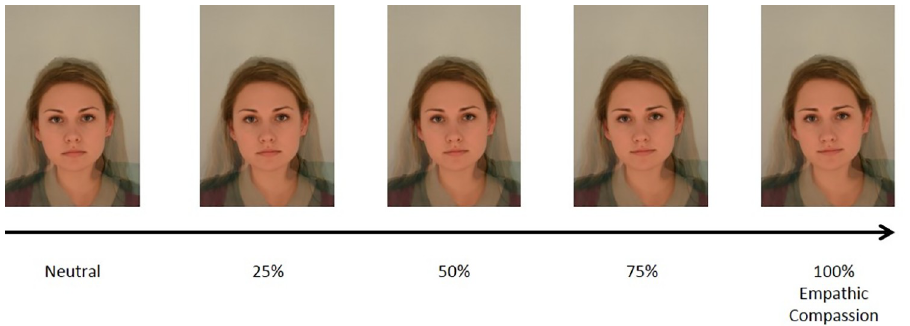
Fig 2. Example of a neutral composite morphed towards the empathic compassion prototype at 25%, 50%, 75% and 100%.